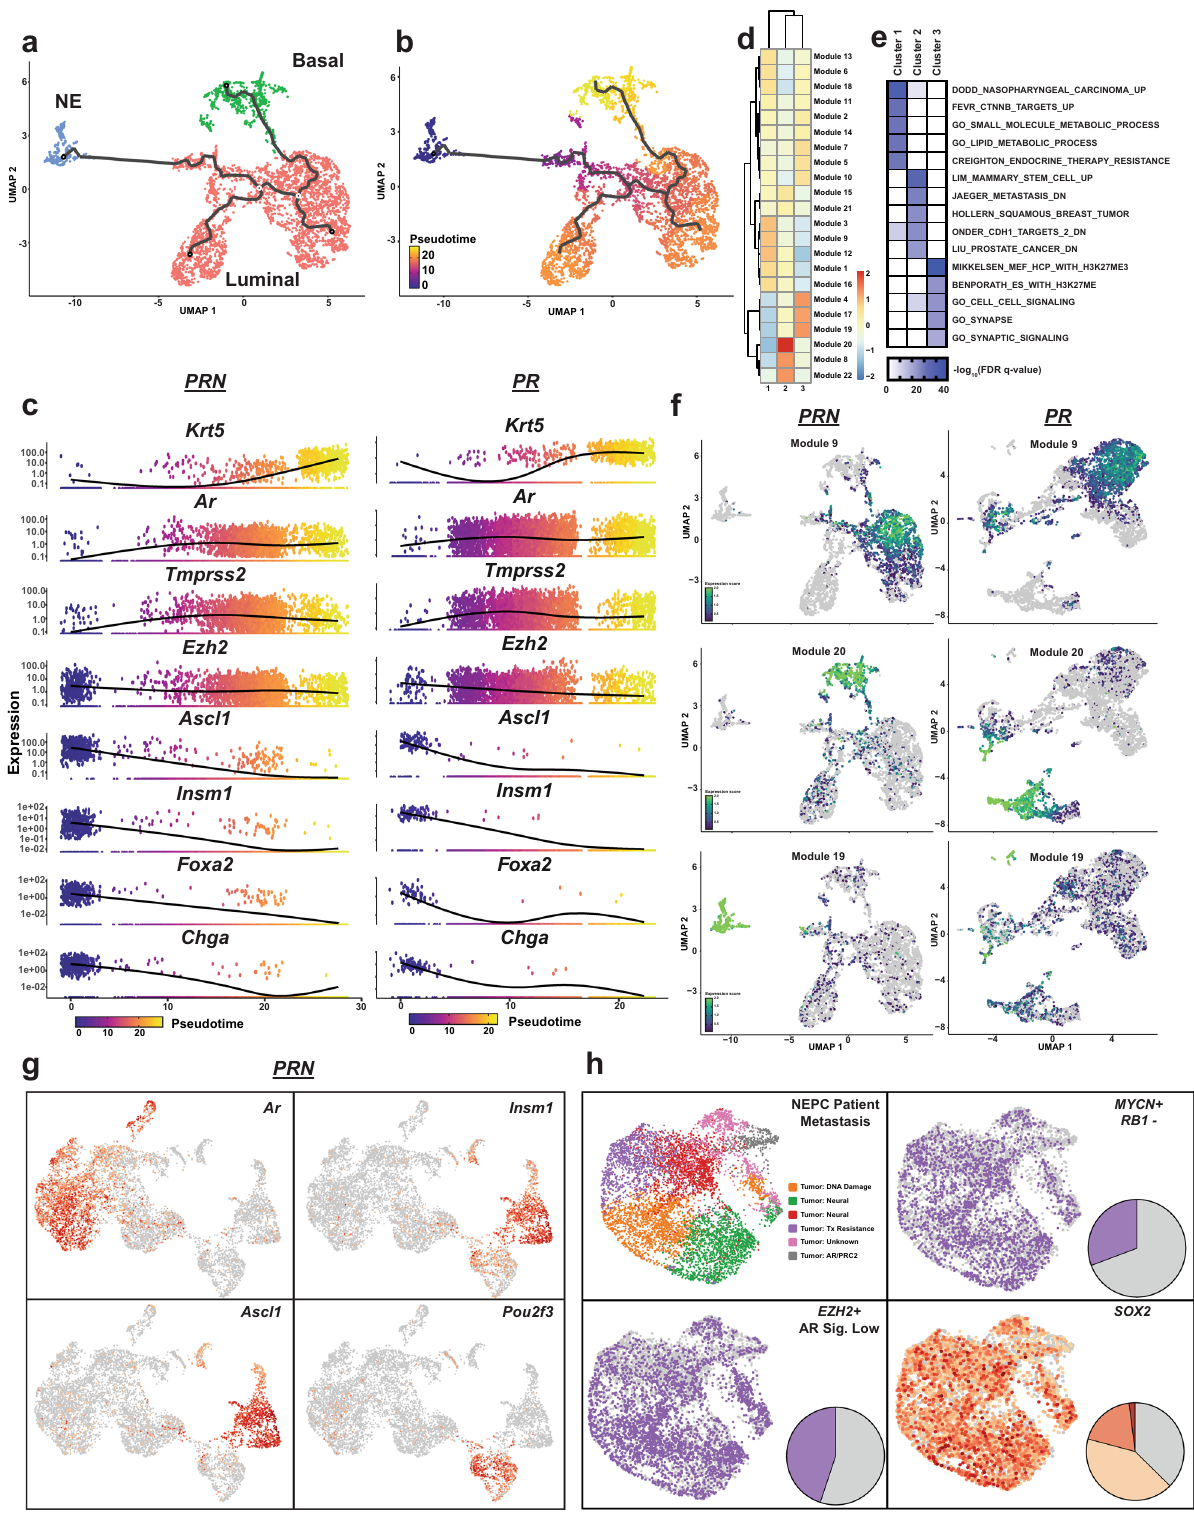
transition towards the neuroendocrine cluster (Supplementary Fig. 4j). Distinct chromatin accessibility patterns exist in neuroendo- crine subpopulations . Based on the transcriptional